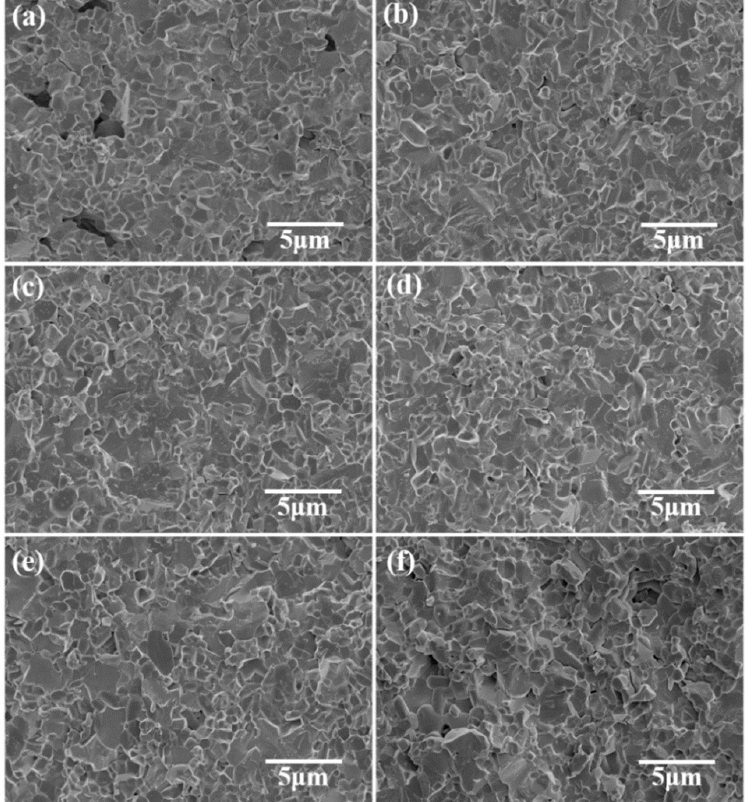
Figure 3. SEM micrographs of the cross-sections of the MLLC ceramics sintered at 800 °C. ( a ) MLL, ( b ) MLLC7.5, ( c ) MLLC8.5, ( d ) MLLC9.5, ( e ) MLLC10.5, and ( f ) MLLC11.5.